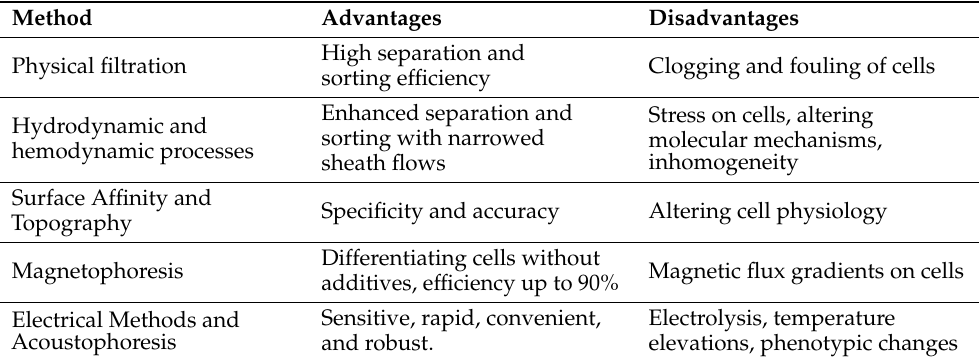
Table 3. Microfluidic Single-RBC Filtering Techniques [257,262,271].